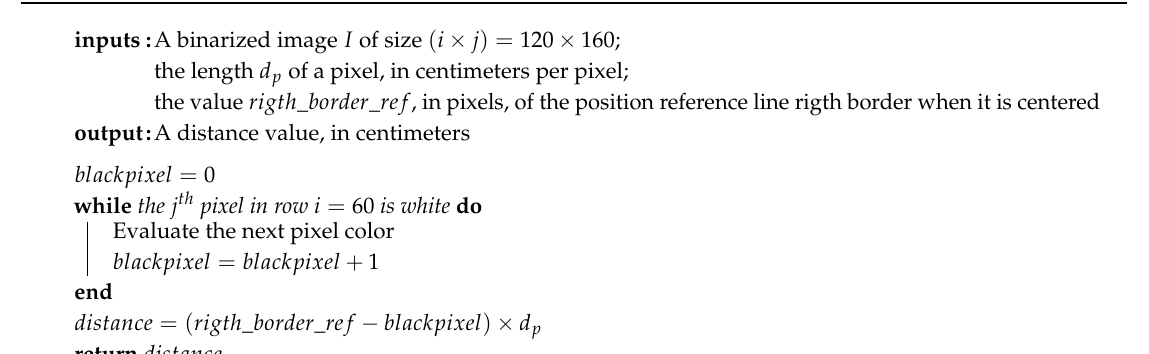
Algorithm 3: Reference line distance from center